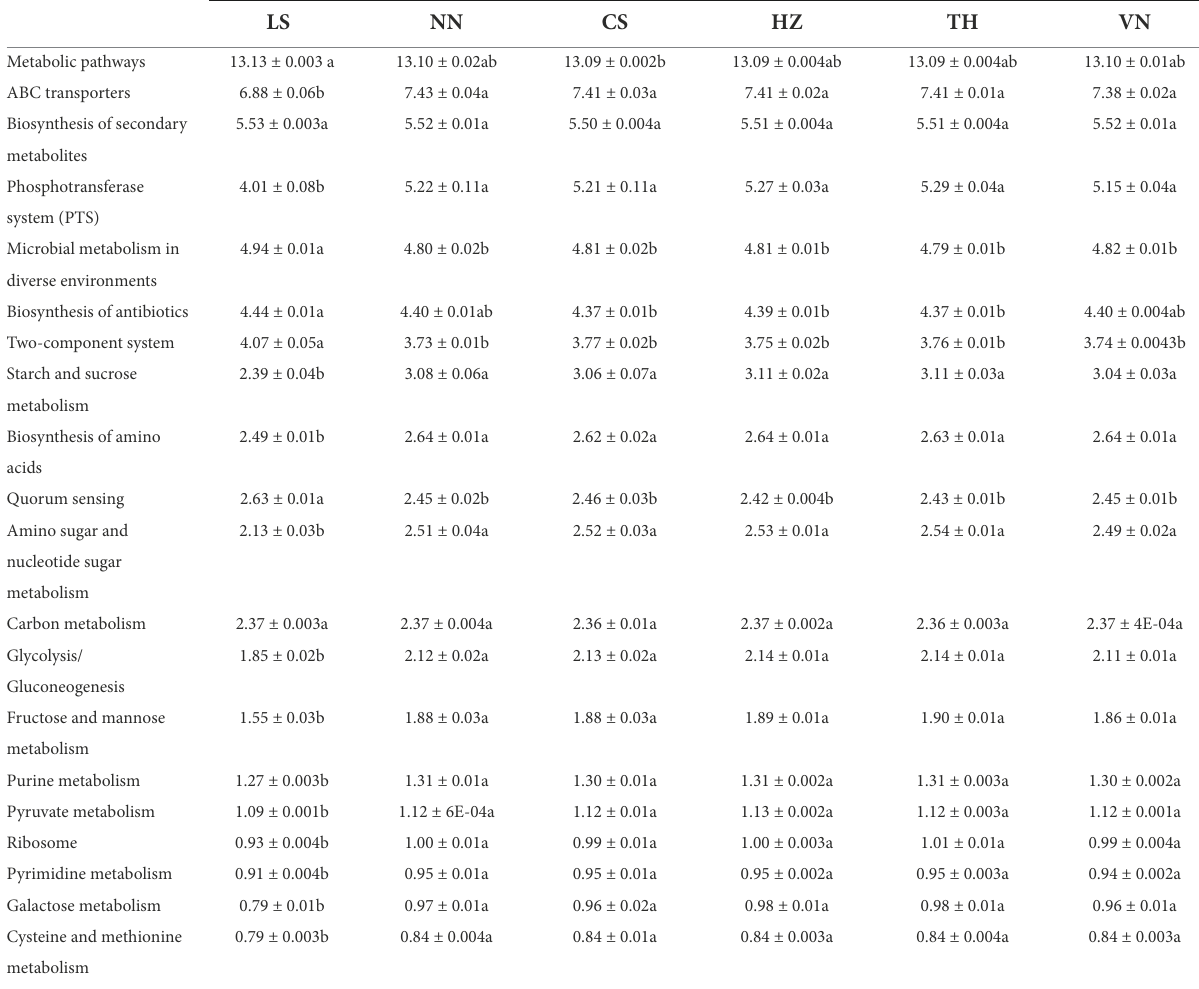
TABLE 4 The relative abundance of the top 20 GO pathway functions (Level 1) of the gut microbiota of Cnaphalocrocis medinalis from geographic sources. Level 1